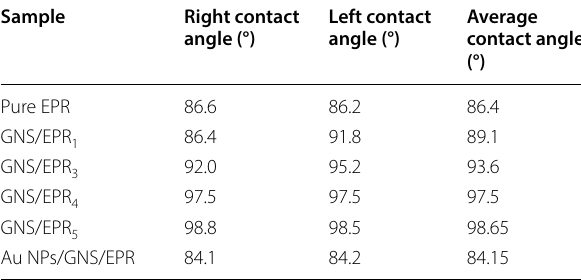
Table 3 The contact angle data of neat EPR, GNS/EPR nanocomposites and its Au NPs/GNS/EPR with water